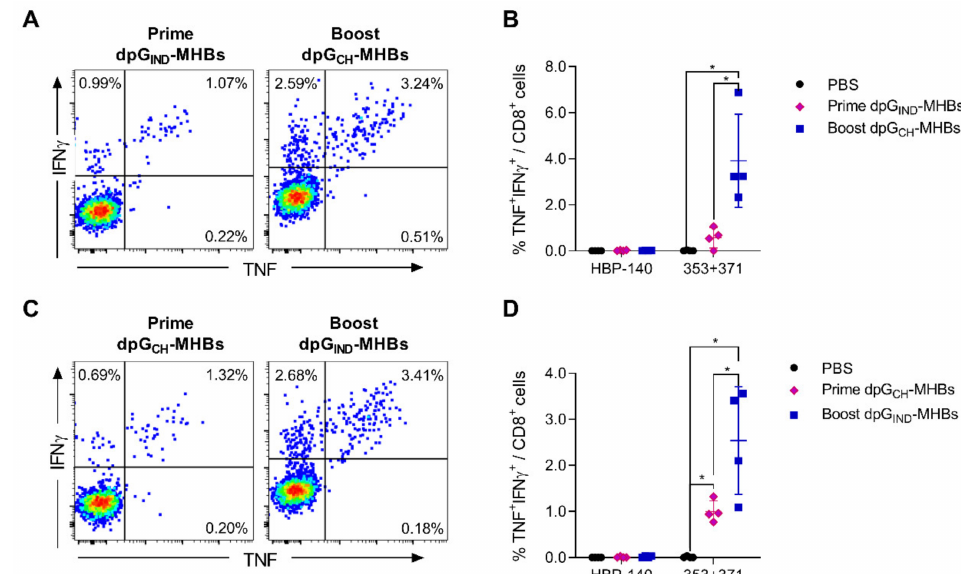
Figure 3. VLV dp homologous prime-boost immunization with glycoprotein switch enhances MHBs-specific splenic CD8 + T cell responses. C57BL / 6 male mice were immunized with 1 × 10